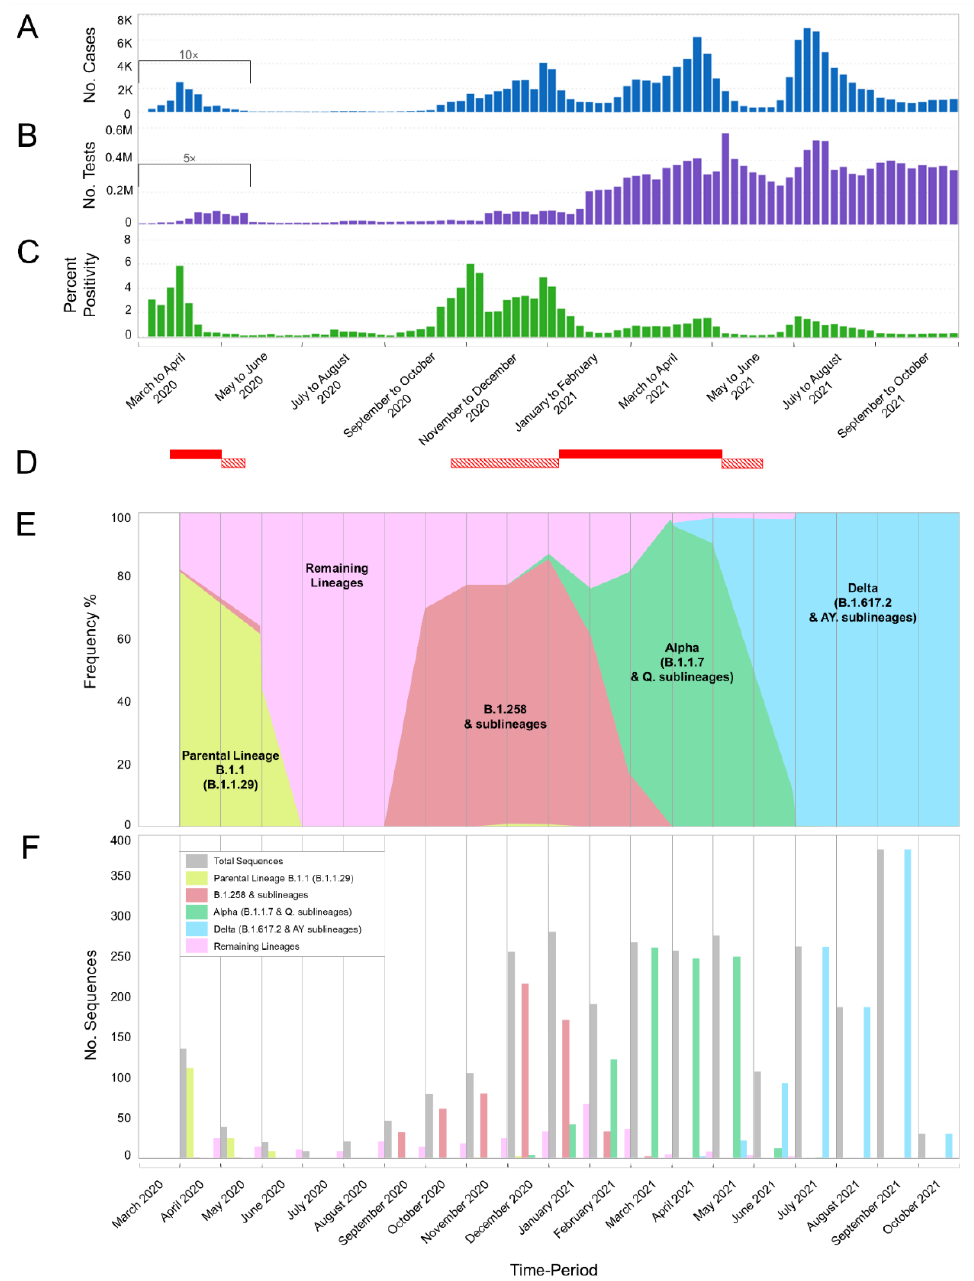
Figure 1. Cases, tests, percent positivity, and most prevalent lineages of SARS-CoV-2 infection in